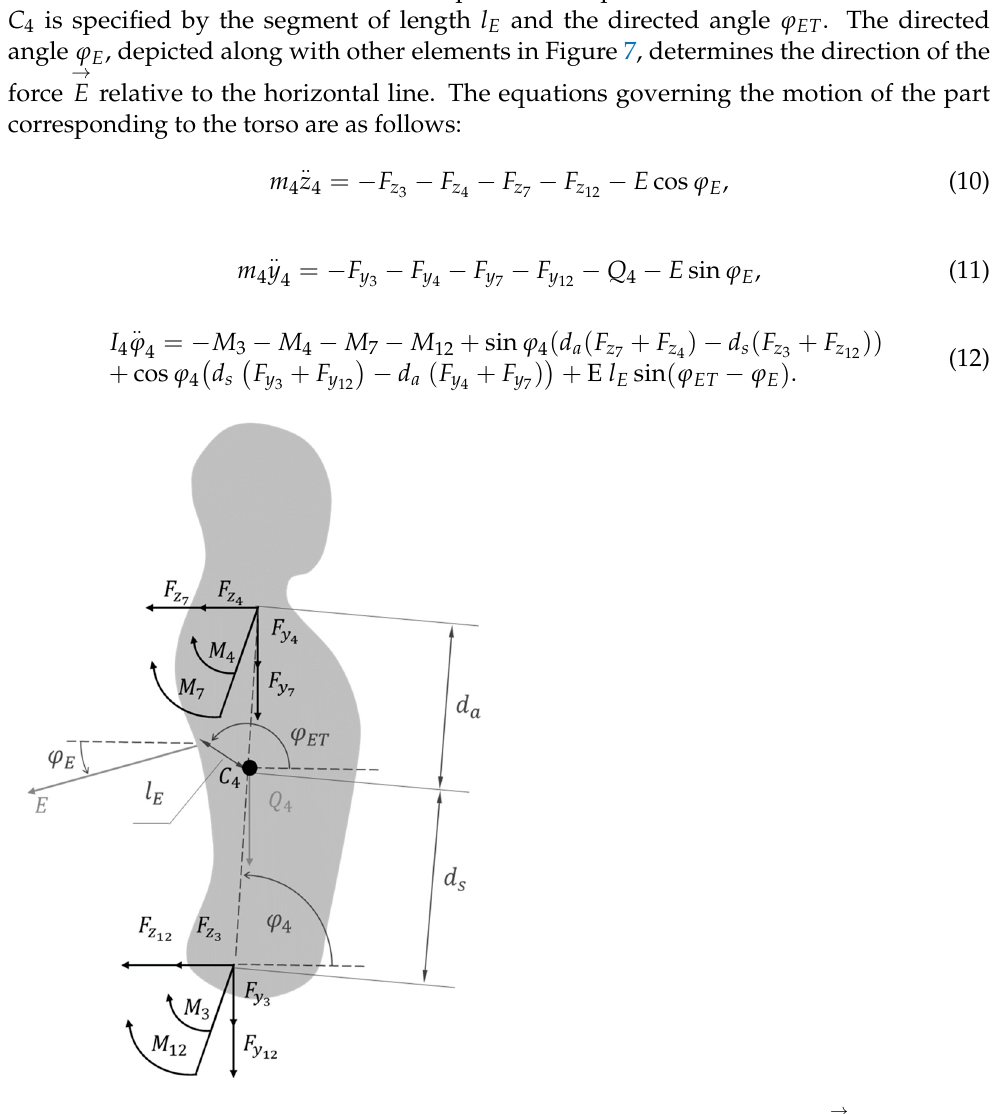
Figure 7. The free-body diagram for the segment representing the head and torso. 𝐸 (cid:4652) ⃗ stands for the external force applied to the participant.